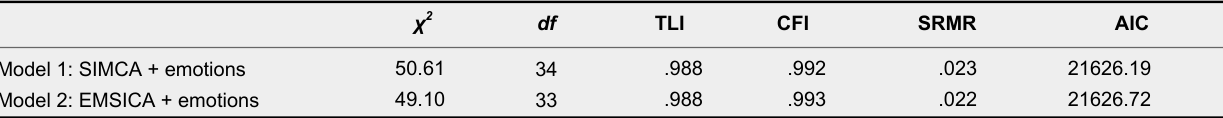
Fit Indexes for the Alternative